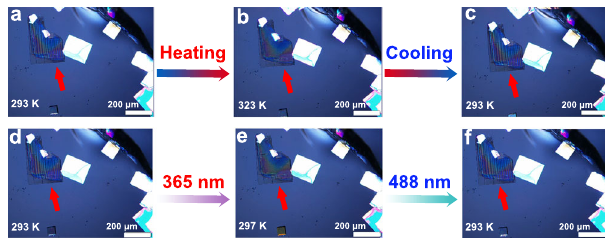
Fig. 3 Evolution of ferroelastic domains. The evolution of ferroelastic domains under the variation of temperature and light for SA-NPh-( S ), the scale bar is 200 μ m. The red arrows point to crystals with ferroelastic domains. a – c Temperature-controlled process: a initial state in Phase I. b Heating into Phase II (erasing). c Cooling back into Phase I (rewriting). d – f Light-controlled process: d initial state in Phase I. e Phase III upon UV light irradiation of 365 nm (erasing). f Returning into Phase I upon visible light irradiation of 488 nm